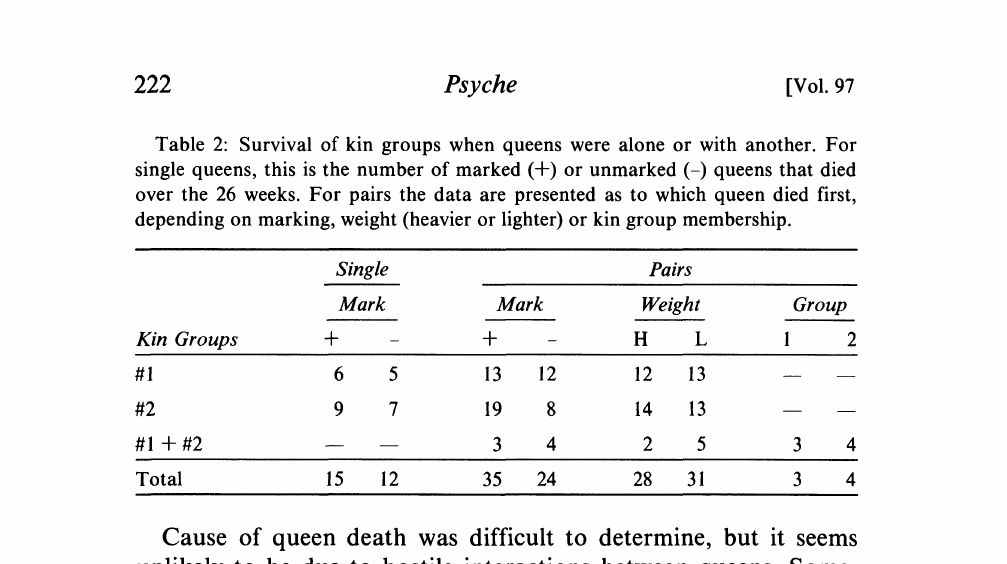
Table 2: Survival of kin groups when queens were alone or with another. For single queens, this is the number of marked (+) or unmarked (-) queens that died over the 26 weeks. For pairs the data are presented as to which queen died first, depending on marking, weight (heavier or lighter) or kin group